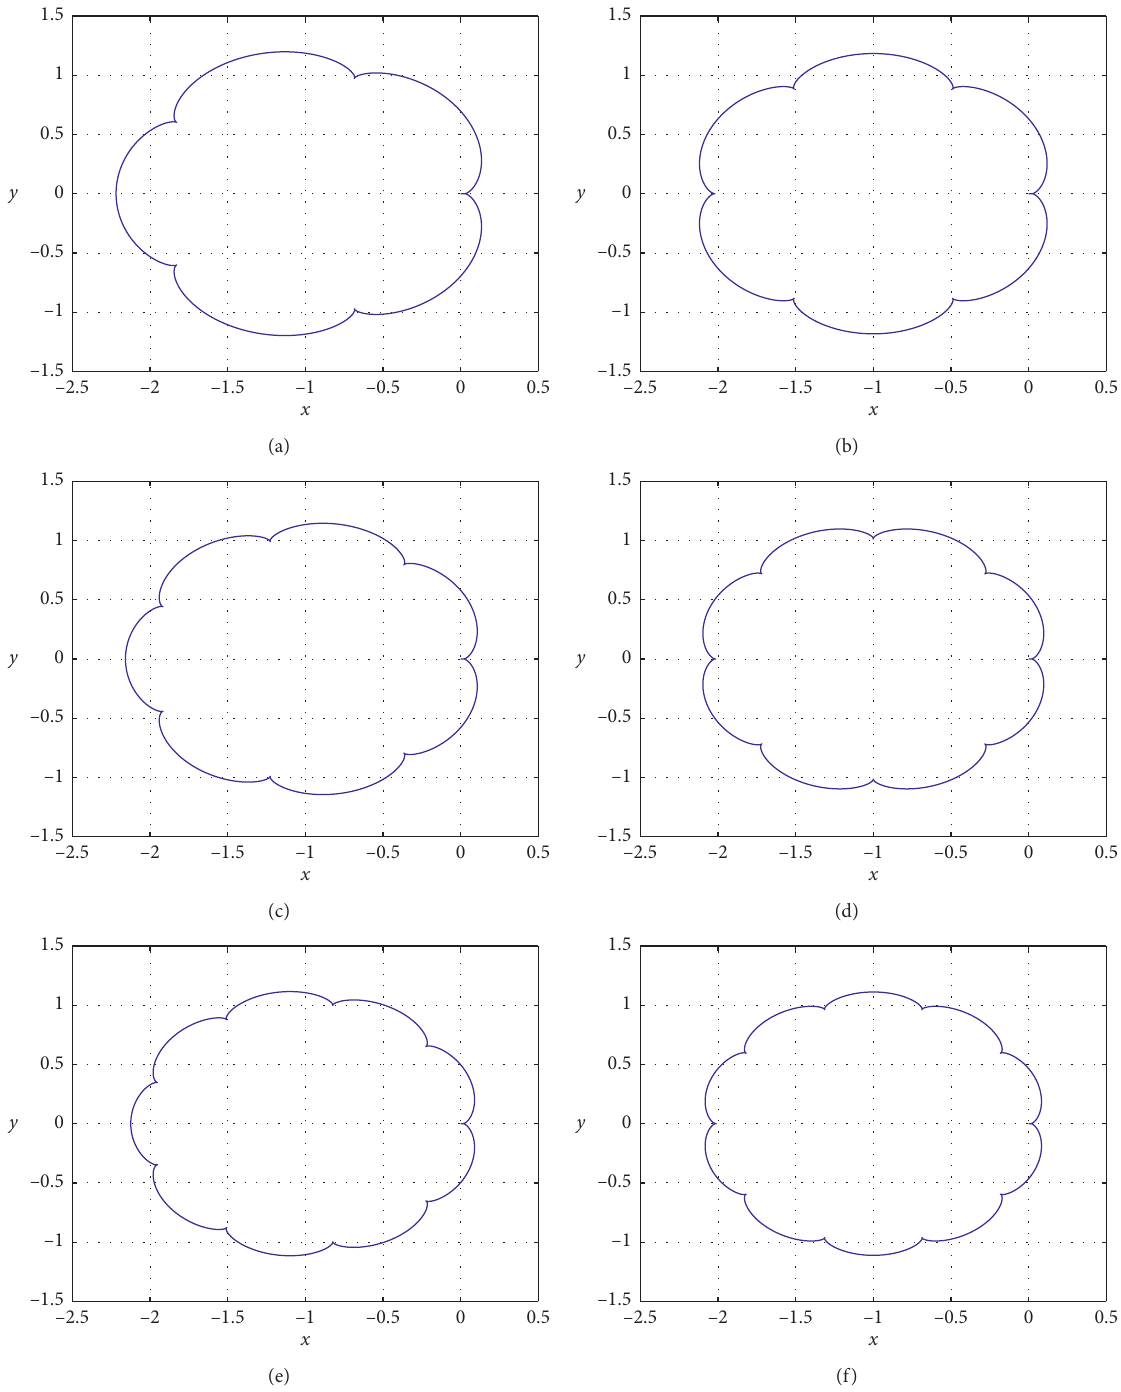
Figure 9: Periodic orbits when e � 0 . 2, f 0 � π /2, and velocity _ y 0 � 0 . 002. (a) Five-loop orbit, when x 0 � 0.024156265. (b) Six-loop orbit, when x 0 � 0.020553885. (c) Seven-loop orbit, when x 0 � 0.01785125. (d) Eight-loop orbit, when x 0 � 0.0157495245. (e) Nine-loop orbit, when x 0 � 0.029191930500. (f) Ten-loop orbit, when x 0 �